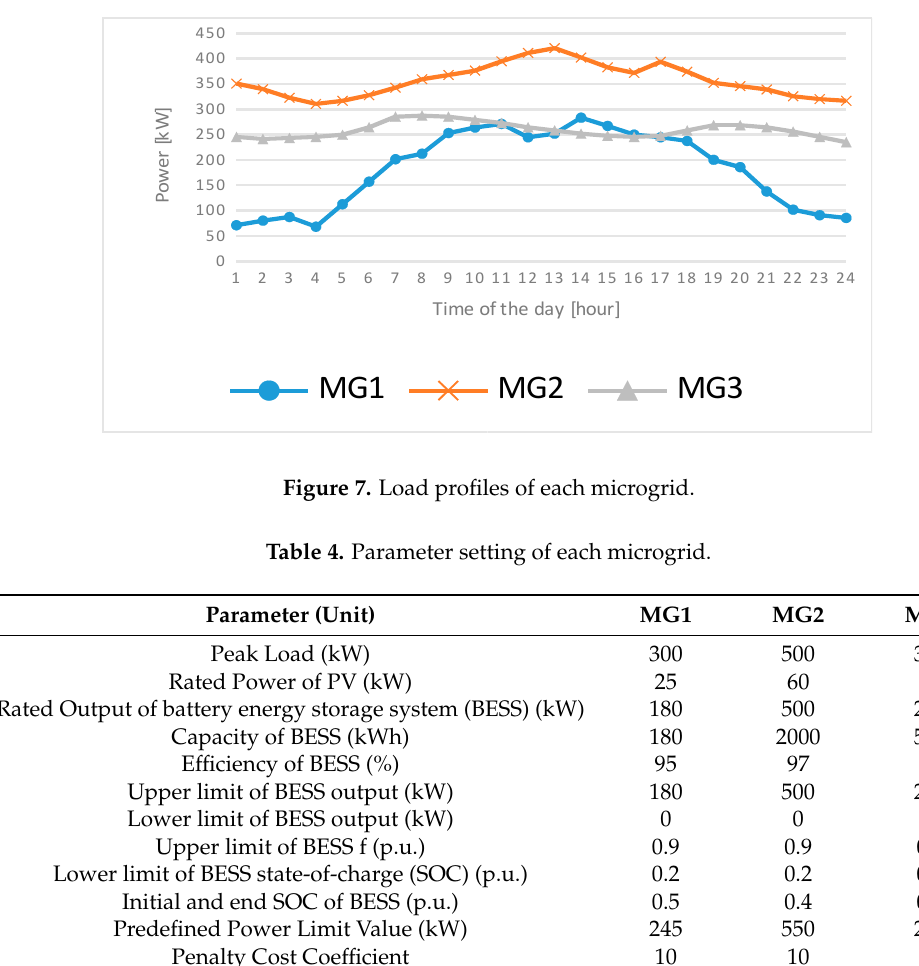
Figure 6. Real-time price profile.